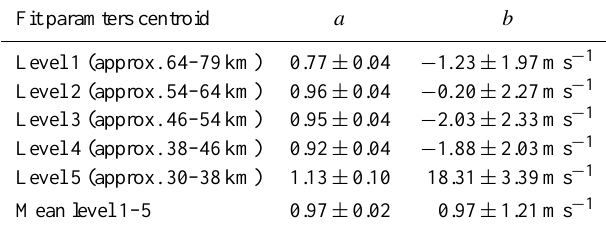
Fig. 10. Ten different input wind profiles with the corresponding retrieved winds for the centroid method. The input wind profile and the associated retrieved winds are plotted in the same colour. The markers for the retrieved wind are positioned at the central altitudes of the WIRA levels. Table 4. Parameters of the fit WIRA = a ECMWF + b for the mea- surement period from 1 September 2010 to 31 July 2011. The data from WIRA are daily average zonal winds retrieved with the cen- troid method. The ECMWF operational analysis data were averaged to the WIRA